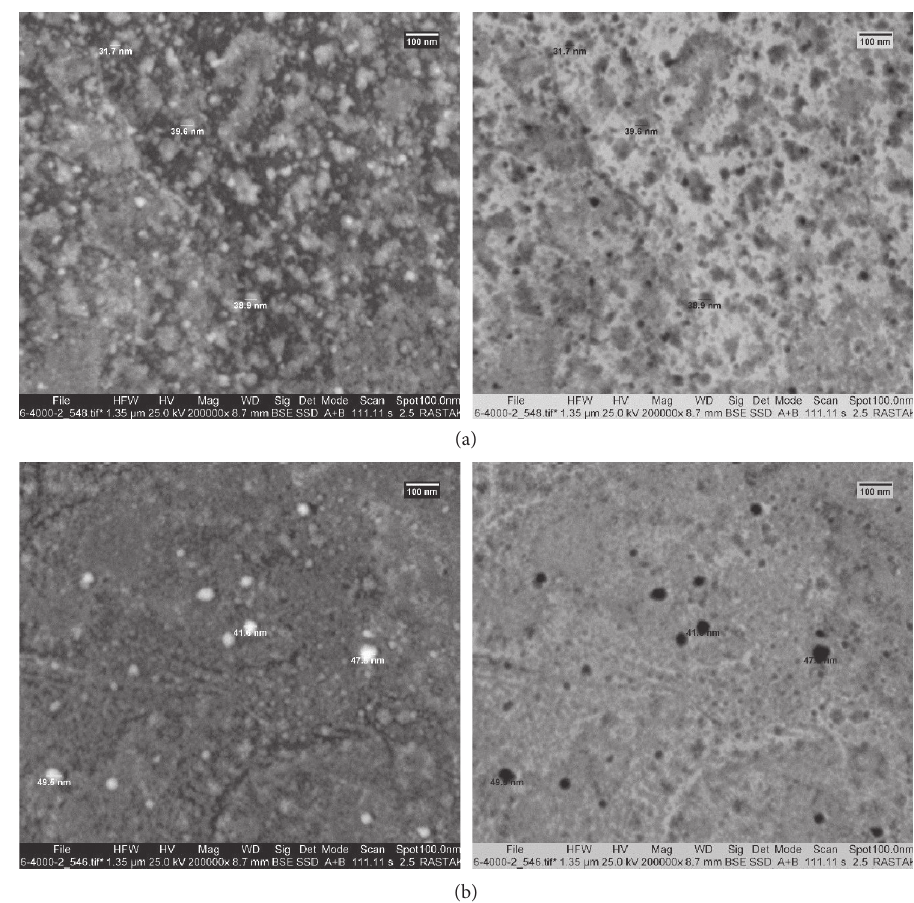
Figure 1: Scanning electron microscopy (SEM) micrographs of CS-NP (a) and GT-CS-NP (b) prepared using an initial weight ratio of CS: GT of